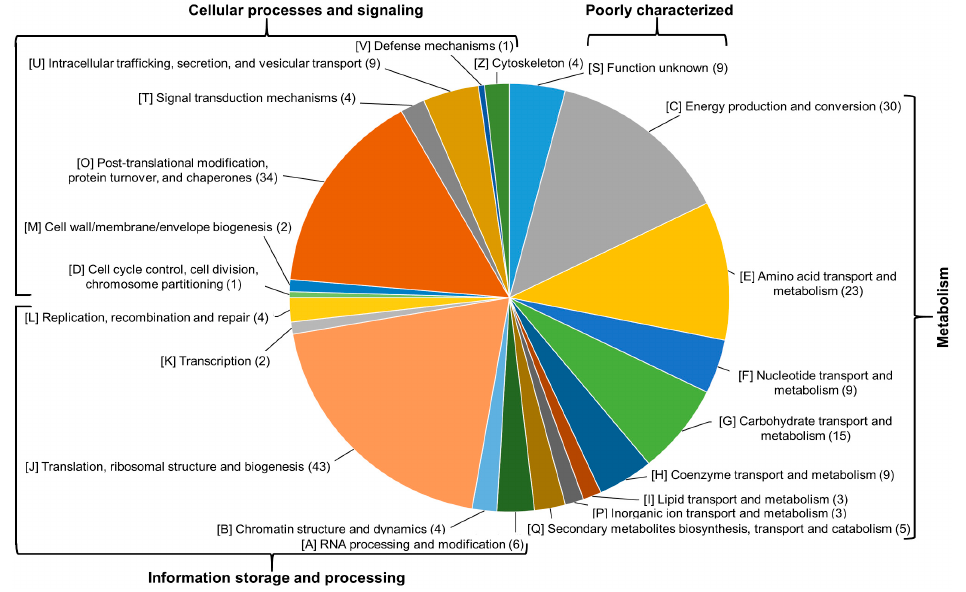
Figure 3. Distribution of proteins based on their Cluster of Orthologous Group (COG) annotation. The number in the brackets at each category represents the actual number of proteins.